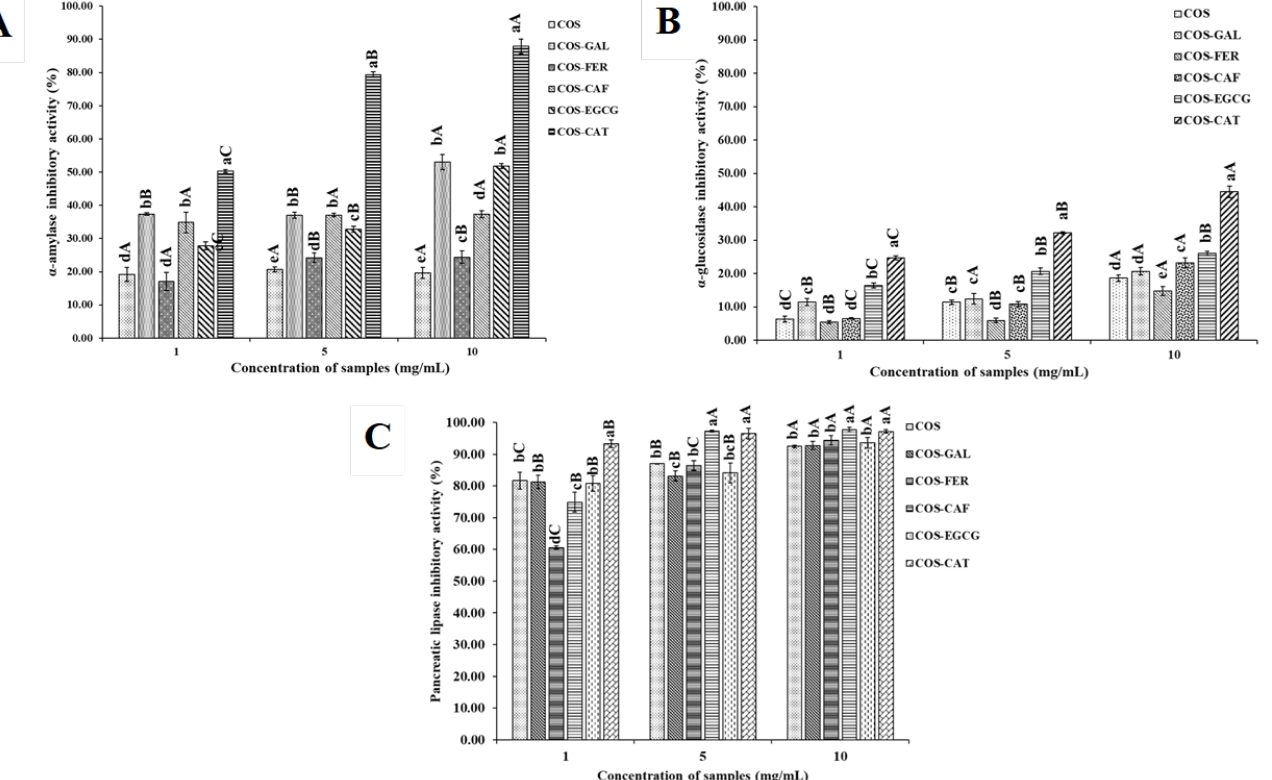
Figure 4. α -amylase ( A ), α -glucosidase ( B ), and pancreatic lipase ( C ) inhibitory activities of COS, COS-GAL, COS-FER, COS-CAF, COS-EGCG, and COS-CAT. Different uppercase superscripts within the same sample indicate significant differences ( p < 0.05); different lowercase superscripts within the same concentration indicate significant differences ( p < 0.05): COS, chitooligosaccharide; GAL, gallic acid; FER, ferulic acid; CAF, caffeic acid; EGCG, epigallocatechin gallate; CAT,